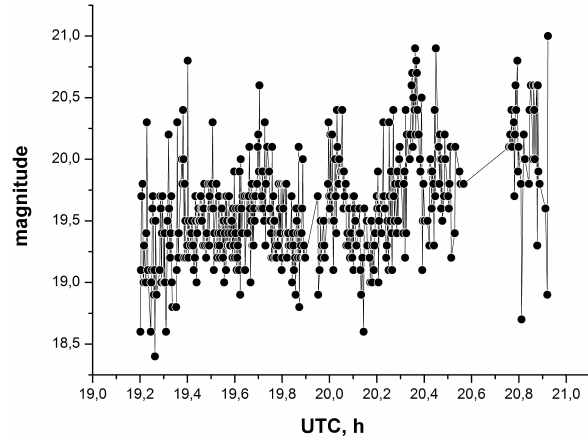
Figure 8. Brightness variations of 99995 object, August 12, 2017.